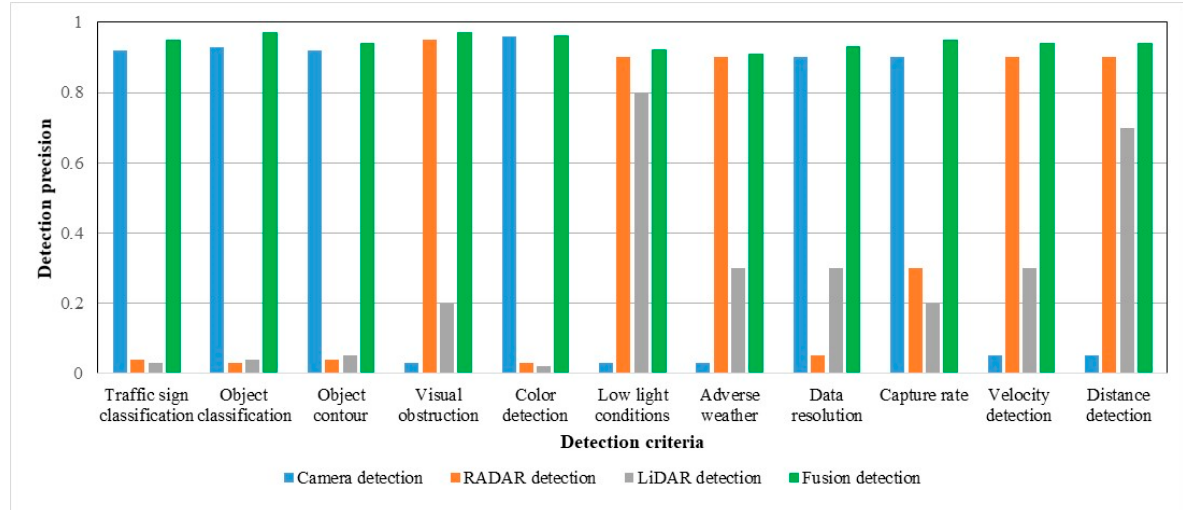
Figure 15. AV sensors fusion detection accuracy estimation with respect to car sensors.